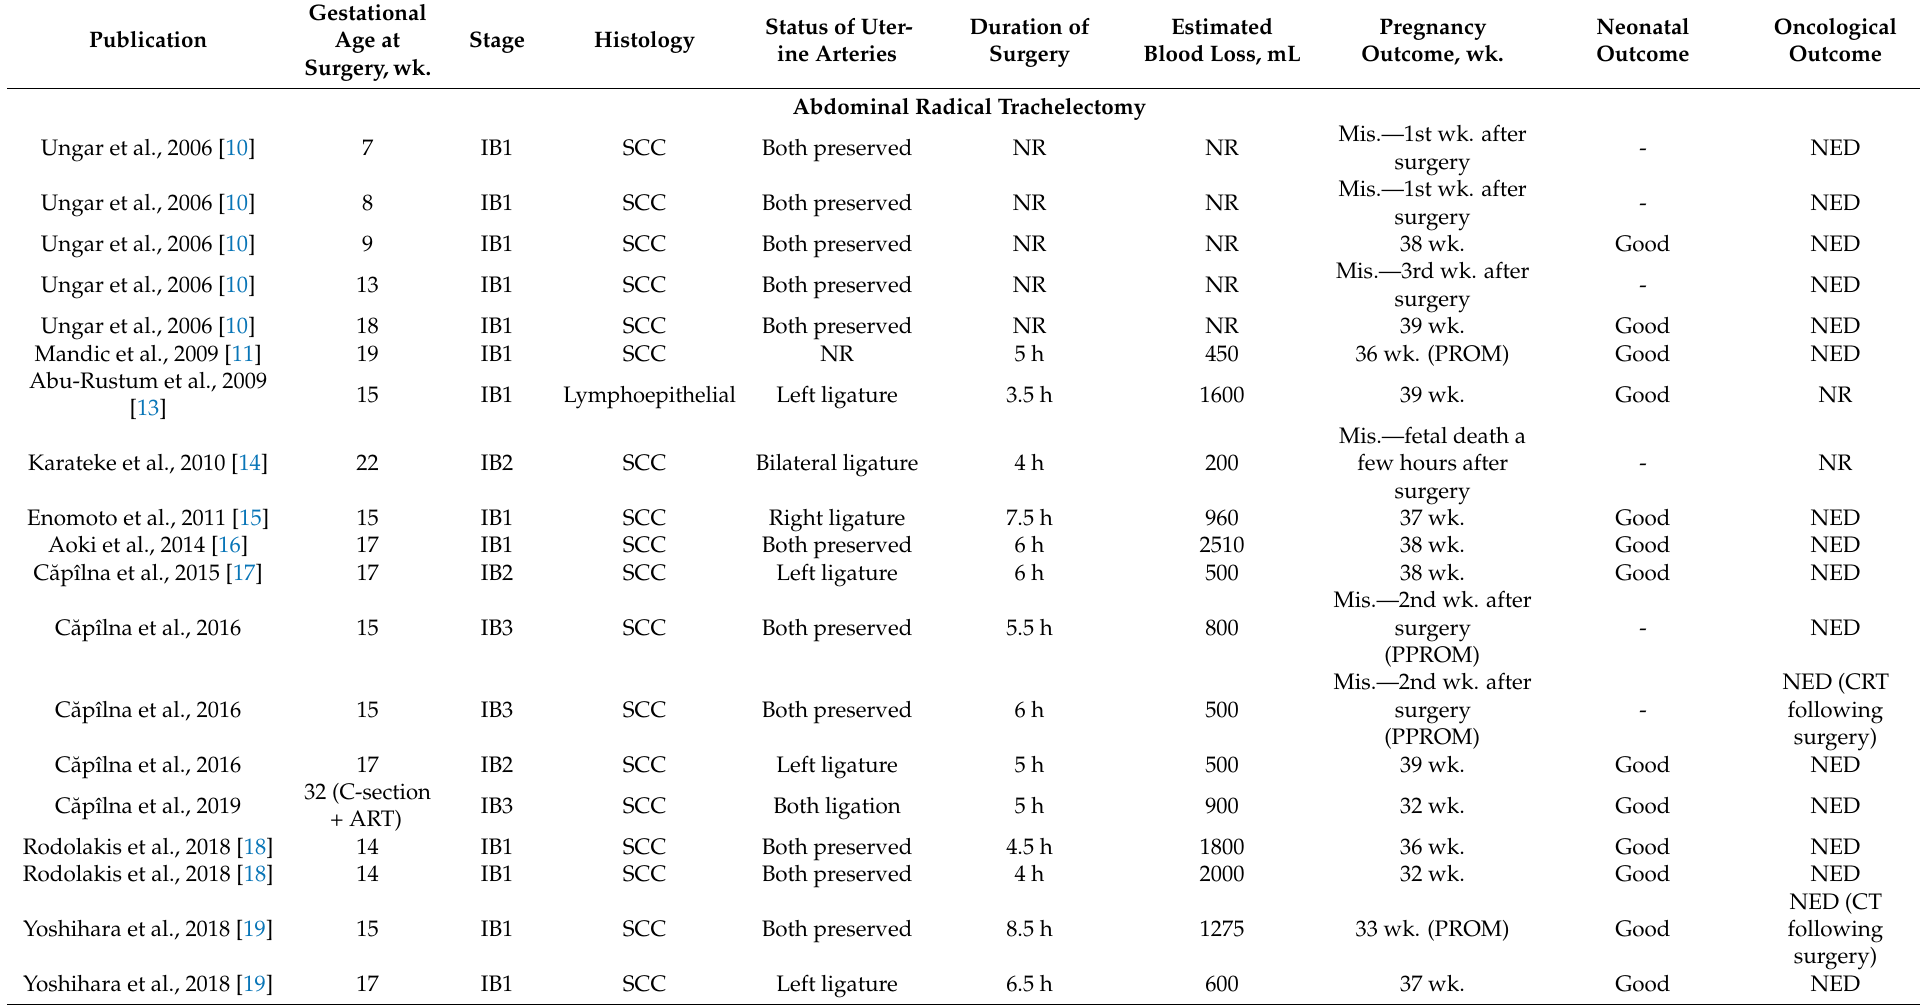
Table 1. Abdominal radical trachelectomy performed during pregnancy—a review of the literature and our institutional